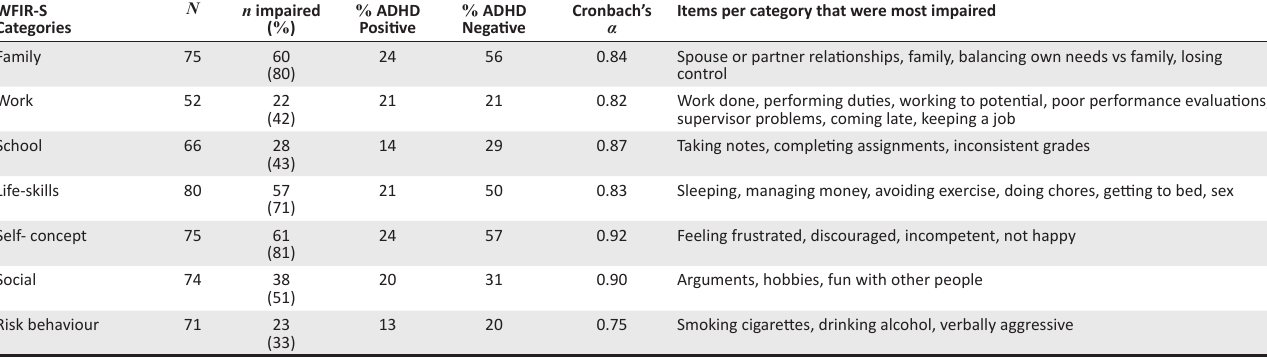
TABLE 1: Descriptive findings of the most impaired items of functioning within each of the main categories of parental functional impairment (WFIR-S). WFIR-S Categories